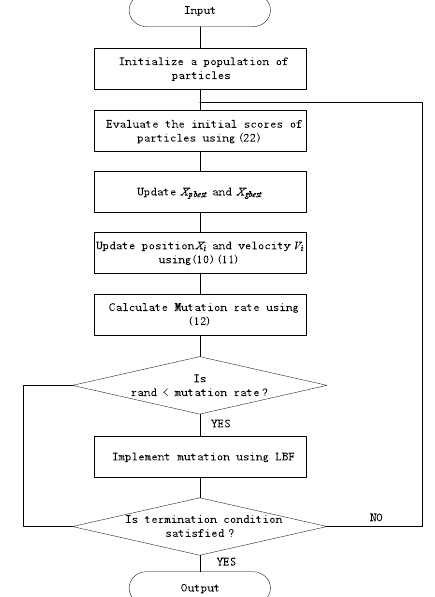
Fig. 5. Flowchart of iPSOA for QoS-aware Web Service Selection